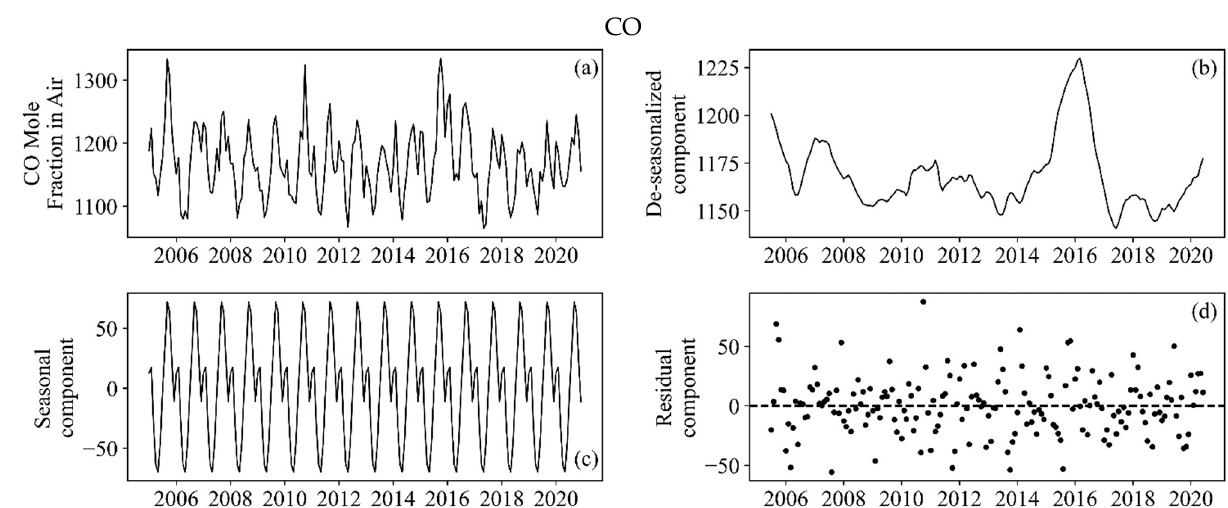
Figure 5. Decomposed time series of NO 2 ( × 10 14 molecules/cm 2 ), SO 2 (DU) and CO (ppbv). All units labelled ( a ) are the monthly series, ( b ) are the de-seasonalized components, ( c ) are the seasonal components and ( d ) are the residual components.